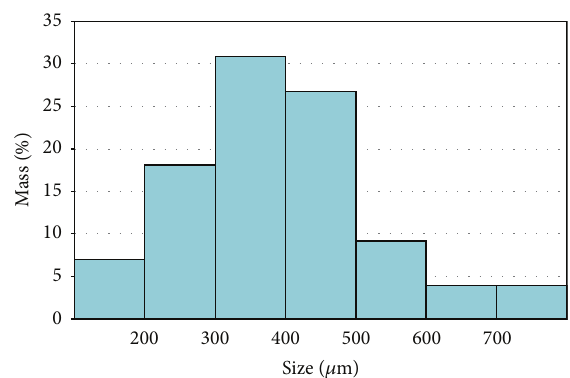
Figure 4: Granule size distribution for spray-dried powder.